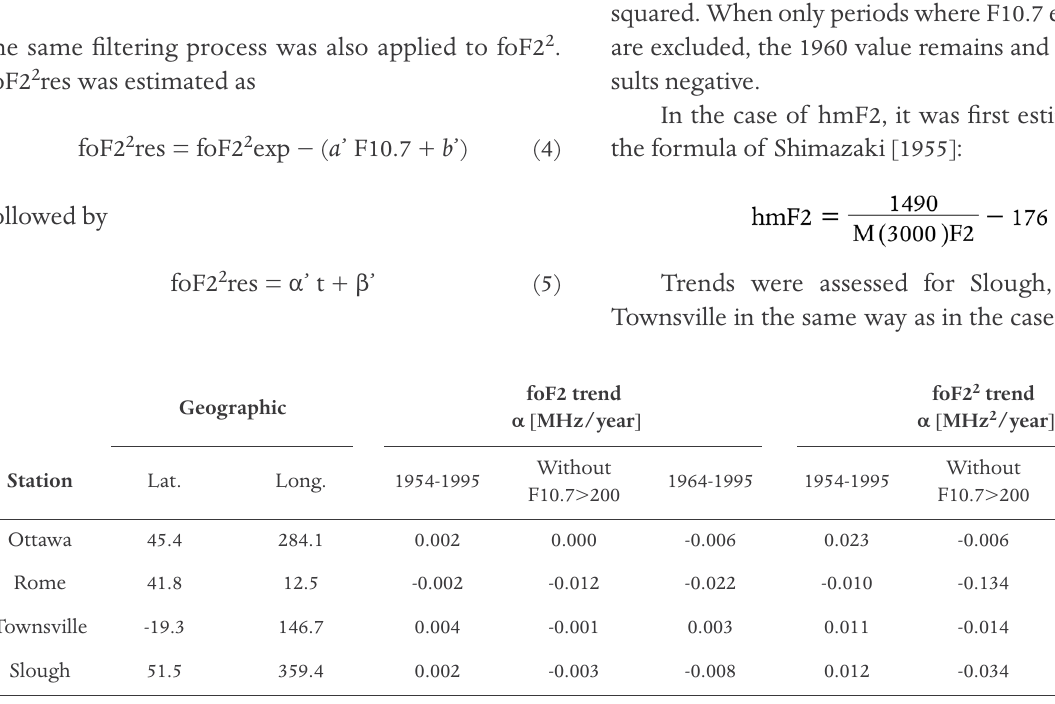
Table 1. Trend values: foF2 and foF2 2 residual trends for four ionospheric stations calculated for three periods: 1954-1995 that includes solar cycle 19, 1954-1995 excluding periods where F10.7 exceeded 200 and 1964-1995 that do not includes cycle 19. Residuals assessed using F10.7 as solar EUV proxy.